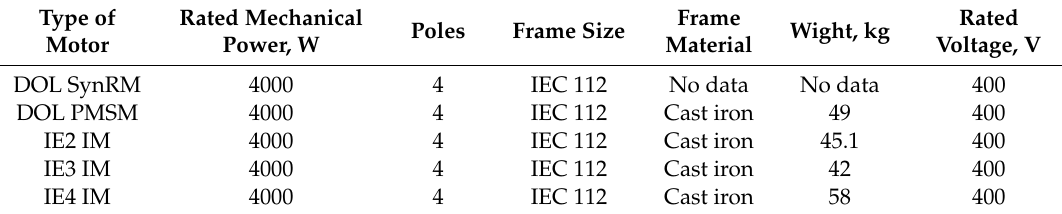
Table 2. Motor characteristics.